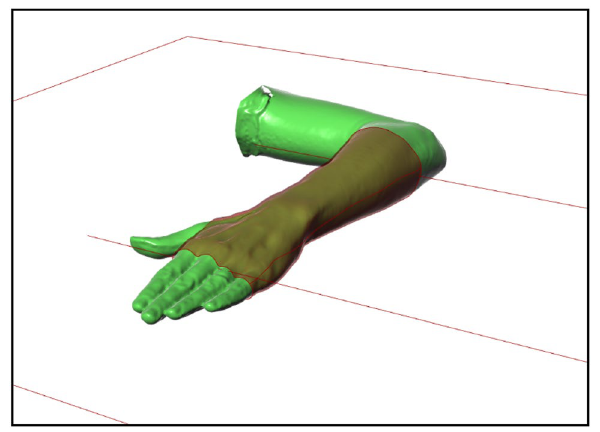
Fig. 7 Cast surface reconstruction and comparison with acquired volume